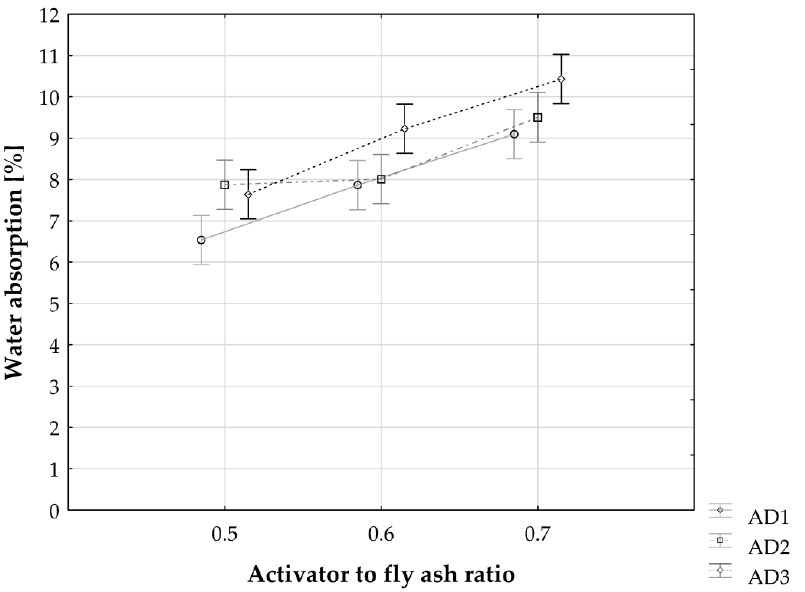
Figure 6. Water absorption results depending on the activator to fly ash ratio (ANOVA certainty in whiskers).